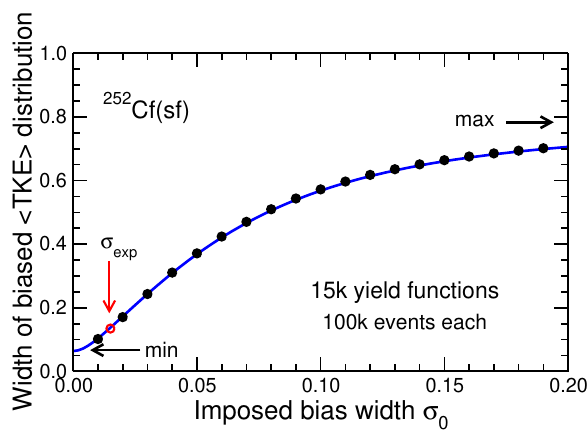
Figure 3. The width of the TKE distribution as a function of bias ) of the individual width σ 0 in the weight W ∼ exp( − δν 2 / 2 σ 2 0 yield functions Y ( A , Z , TKE), as extracted for specific values of σ 0 (dots) or as given in the analytical expression (9) (curve). The is indicated by the circle. The calcu- value obtained using σ eval 0 lations sampled 100,000 fission events from each of the 15,000 yield functions. (From Ref.